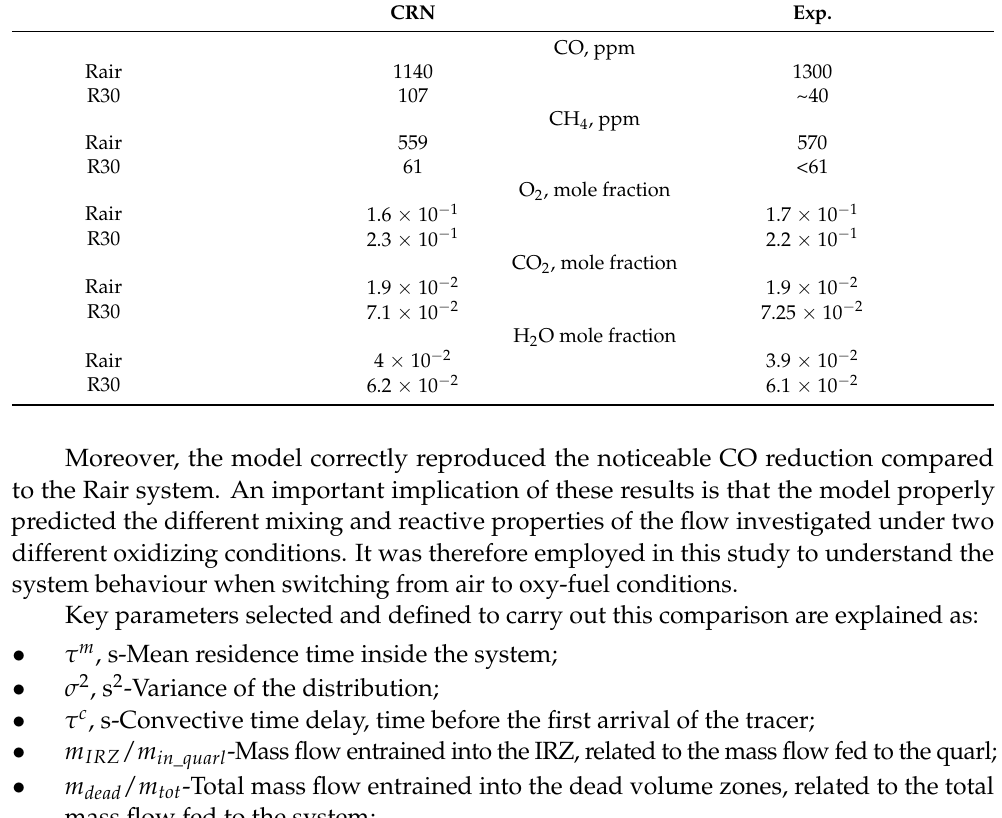
Table 2. Comparison between experimental data [53] and CRN-predicted species concentration near the exit of the combustor. “Exp.” data reproduced with permission from ref. [53], 2018, Elsevier. CRN Exp. CO, ppm Rair 1140 1300